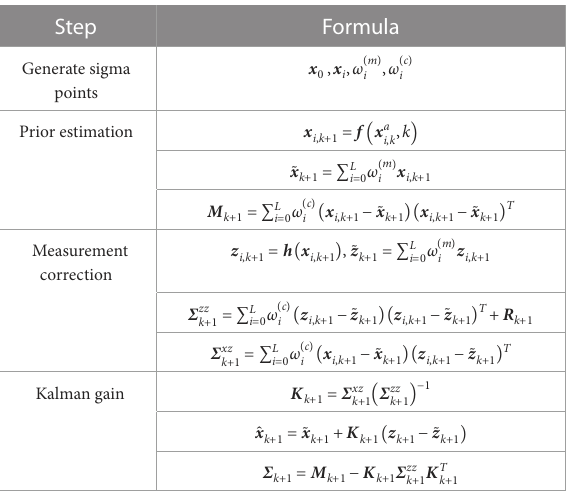
TABLE2 EquationsofUKF. Step